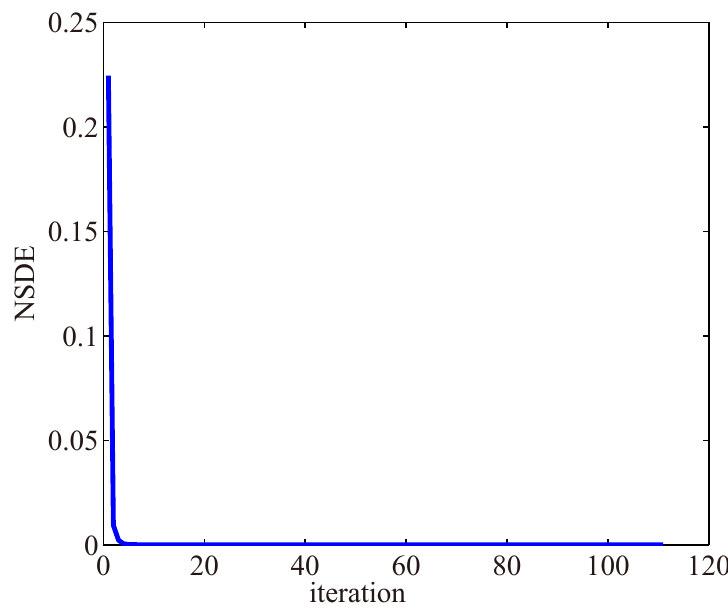
Figure 12. Convergence property of proposed method. The horizontal axis and vertical axis represent the iteration numbers and NSDE,